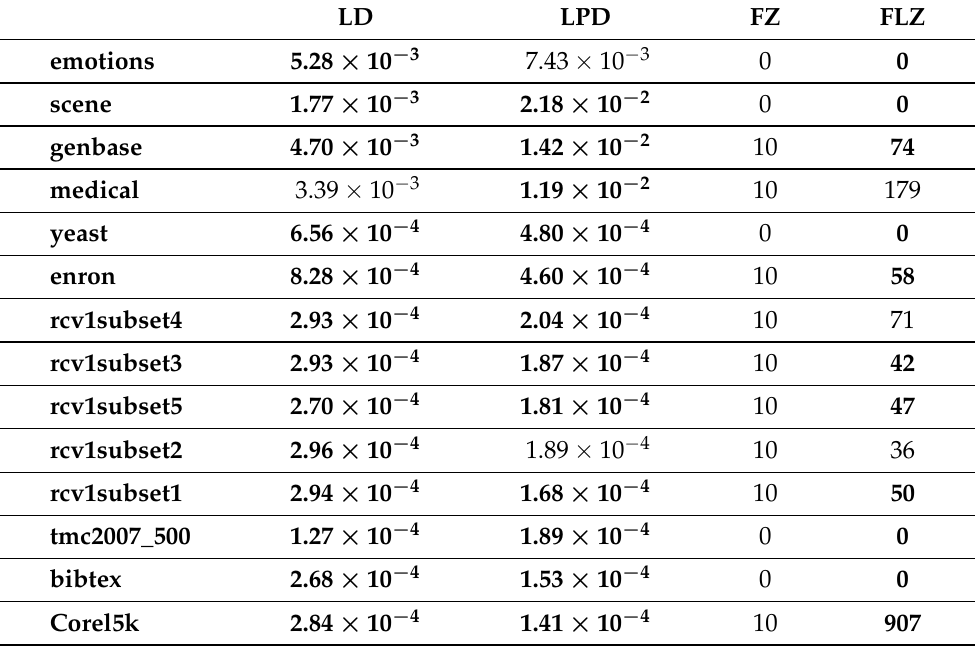
Table 8. Evaluation of the MOEA approach without considering the constraint. In bold the results that are better than the Stratification method.